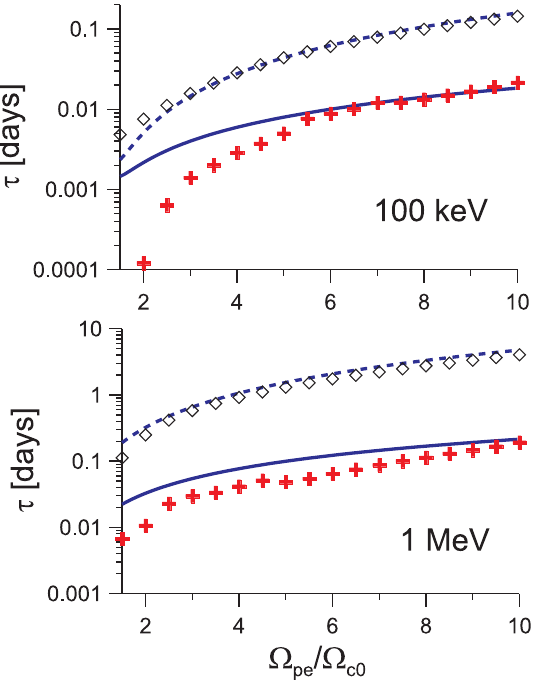
Fig. 14. Electron lifetimes for two values of particle energy, for quasi-parallel and oblique chorus waves. Full numerical solutions as well as the corresponding analytical estimates in Eqs. (9) and (12) are displayed as a function of (cid:127) pe